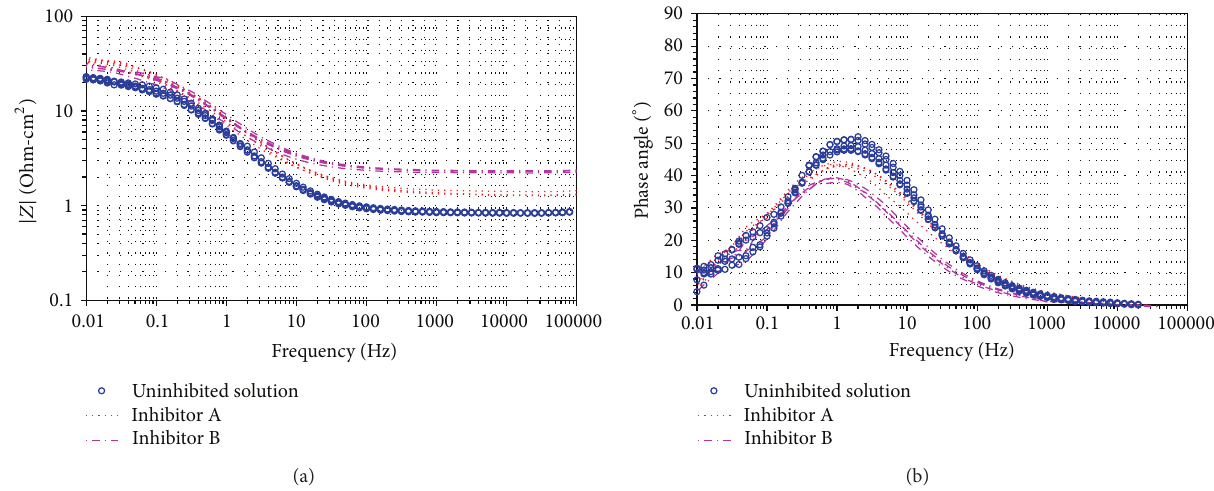
Figure 2: Bode plots in the (a) impedance module and (b) phase angle format for carbon steel in the 3% NaCl + diesel solution with and without inhibitors A and B at 50 ∘